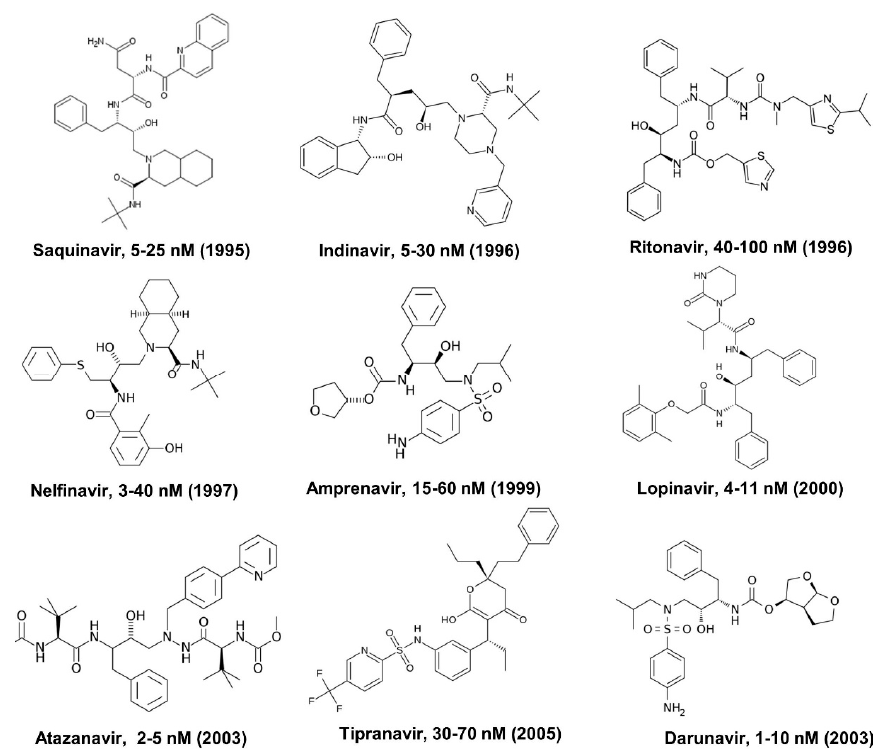
Figure 4. FDA-approved HIV protease inhibitors with approved year and EC 50 values against HIV-1 in cell culture. in cell